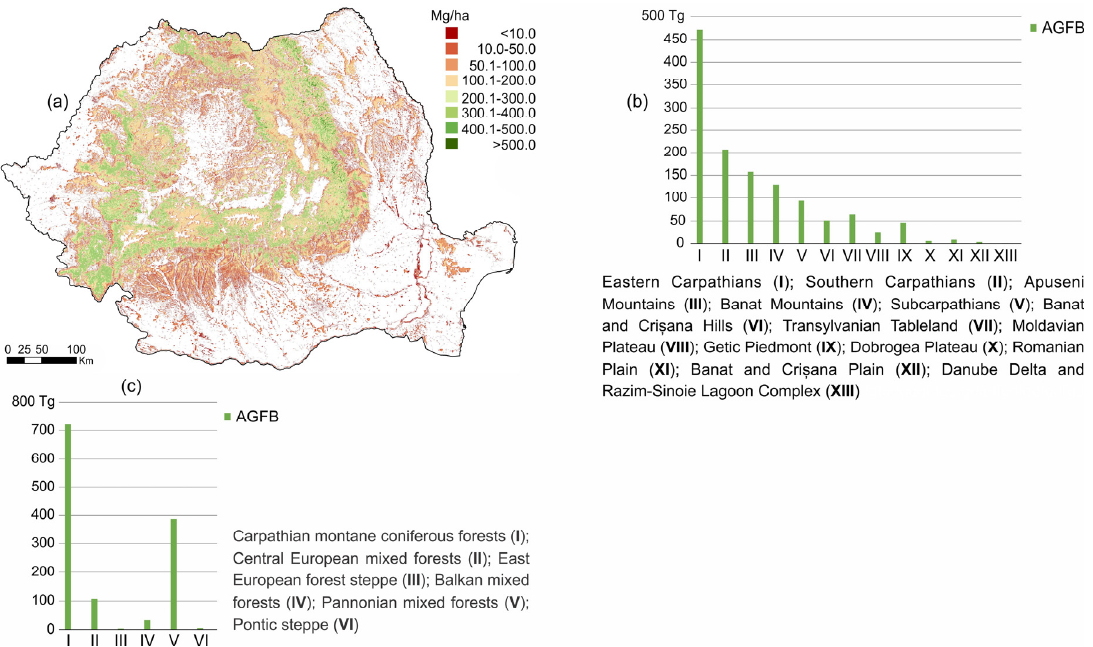
Figure 6. The obtained map of AGFB for 2015 ( a ), and the regional variation at the major landform units ( b ) and the major vegetation ecoregions ( c ) (processed by [47]).